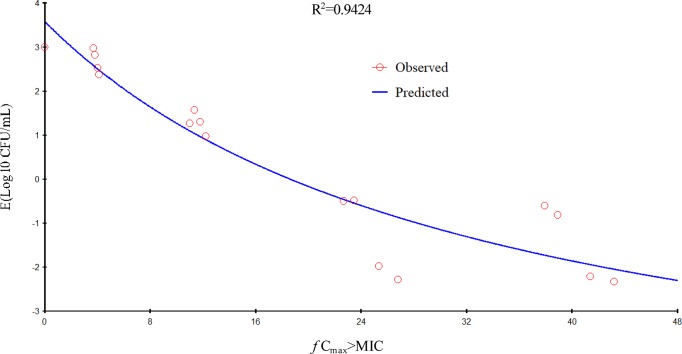
Relationship of f Cmax/minimum inhibitory concentration (MIC) for Pasteurella multocida NM-5-7 with the change in the log10 number of colony-forming unit (CFU)/lung after 24 h of therapy. R
2 is the correlation coefficient.